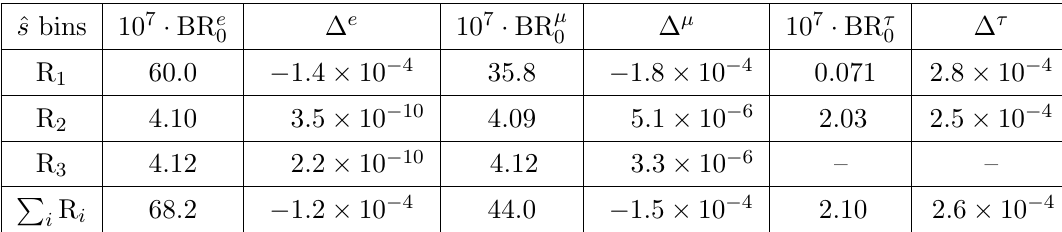
Table 2 . Results for the total branching ratio BR ‘ of B ! X s ‘ + ‘ (cid:0) , integrated on the various R i bins of ^ s as de(cid:12)ned in the text, where BR ‘ = BR ‘ magnetic-dipole